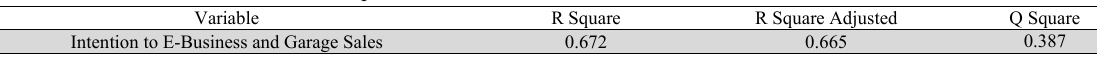
Results the coefficient determination and predictive relevance